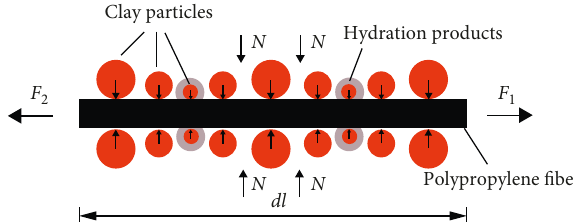
Figure 15: The schematic diagram of the friction between poly- propylene fiber and soil-cement.